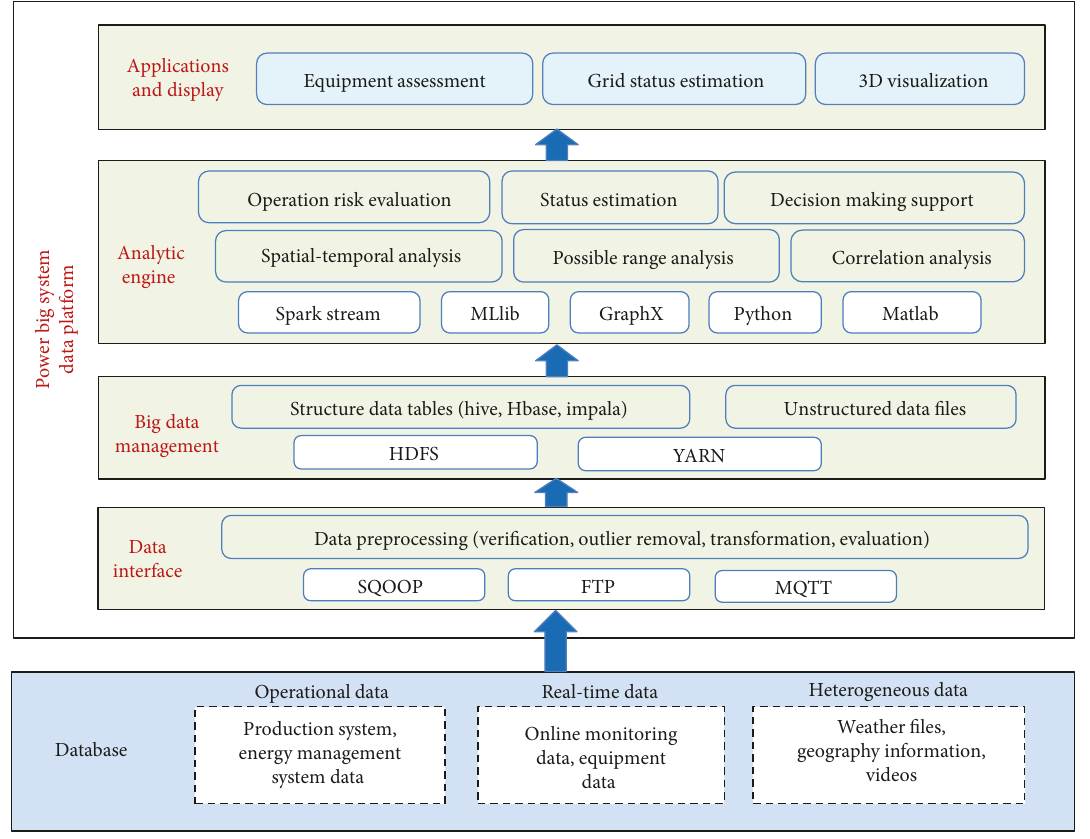
Figure 5: Big Data processing and analysing platform for electric power system condition